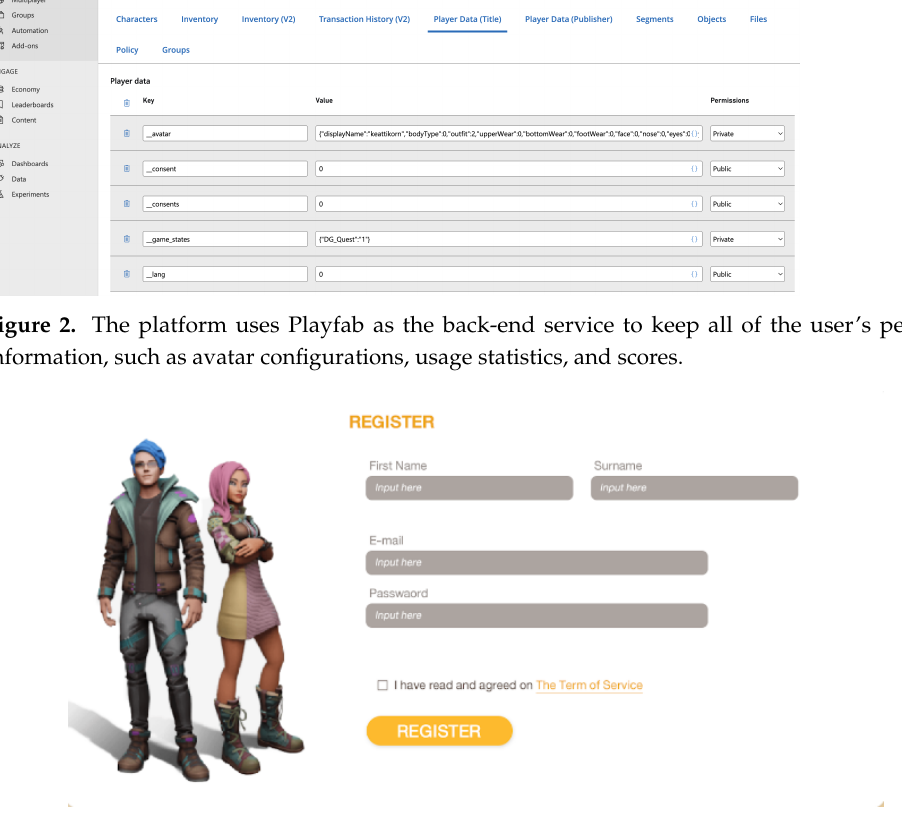
Figure 3. The platform utilises a common form of registration procedure by having a user fill in the form with necessary information and agree to the terms of service. Then, an email is sent to the provided e-mail address for the user to confirm the registration.